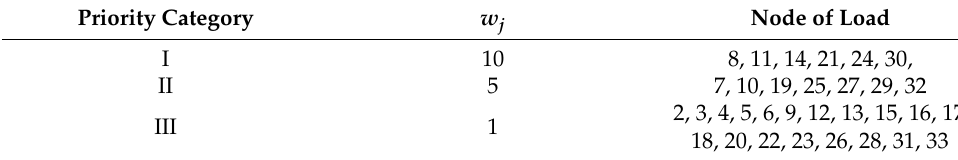
Table 2. Basic installation parameters of the